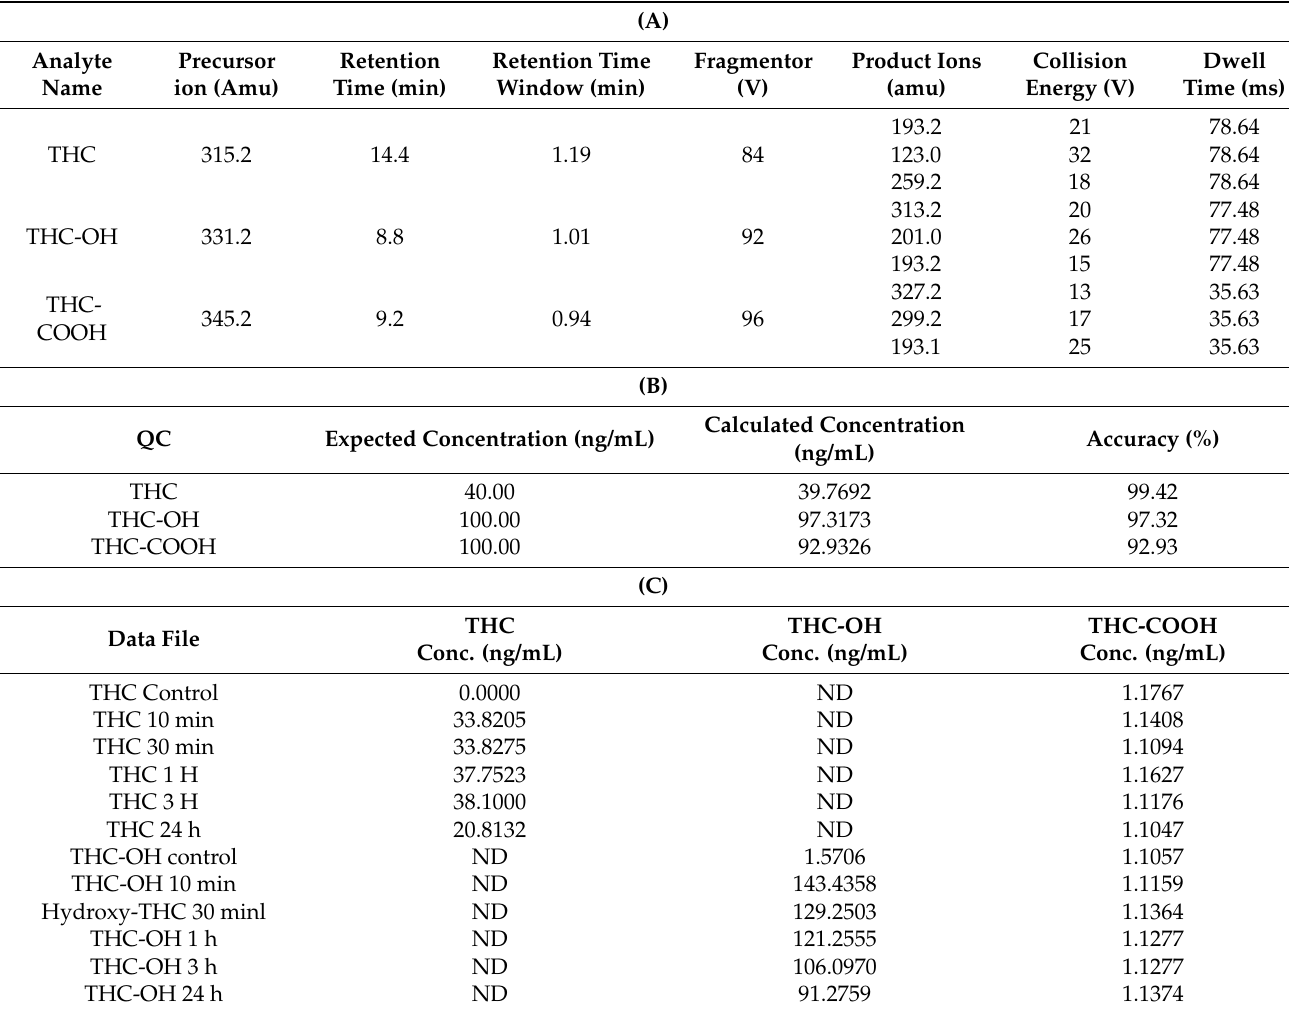
Table 1. H9c2 cardiomyocytes do not metabolize cannabinoids in vitro. ( A ) Ion transitions and mass spectrometry parameters for the LC-MS quantification method of cannabinoids ( B ) In all analysis quality control samples (QC) of extracted spiked media were run alongside samples. These QC demonstrated a calculated concentration accuracy of 90–100%. ( C ) THC treatments of 100 ng/mL resulted in a media concentration of 33 ng/mL after 10 mins of collection, with an approximate 30% decrease over 24 h in THC